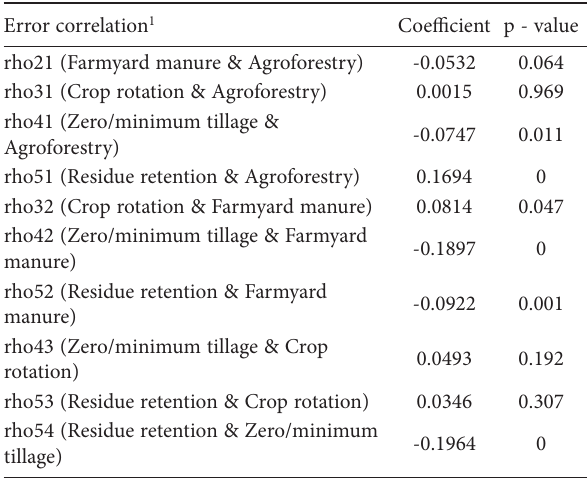
Table 5. Results of the Wald Test of Simultaneity of the decisions to adopt